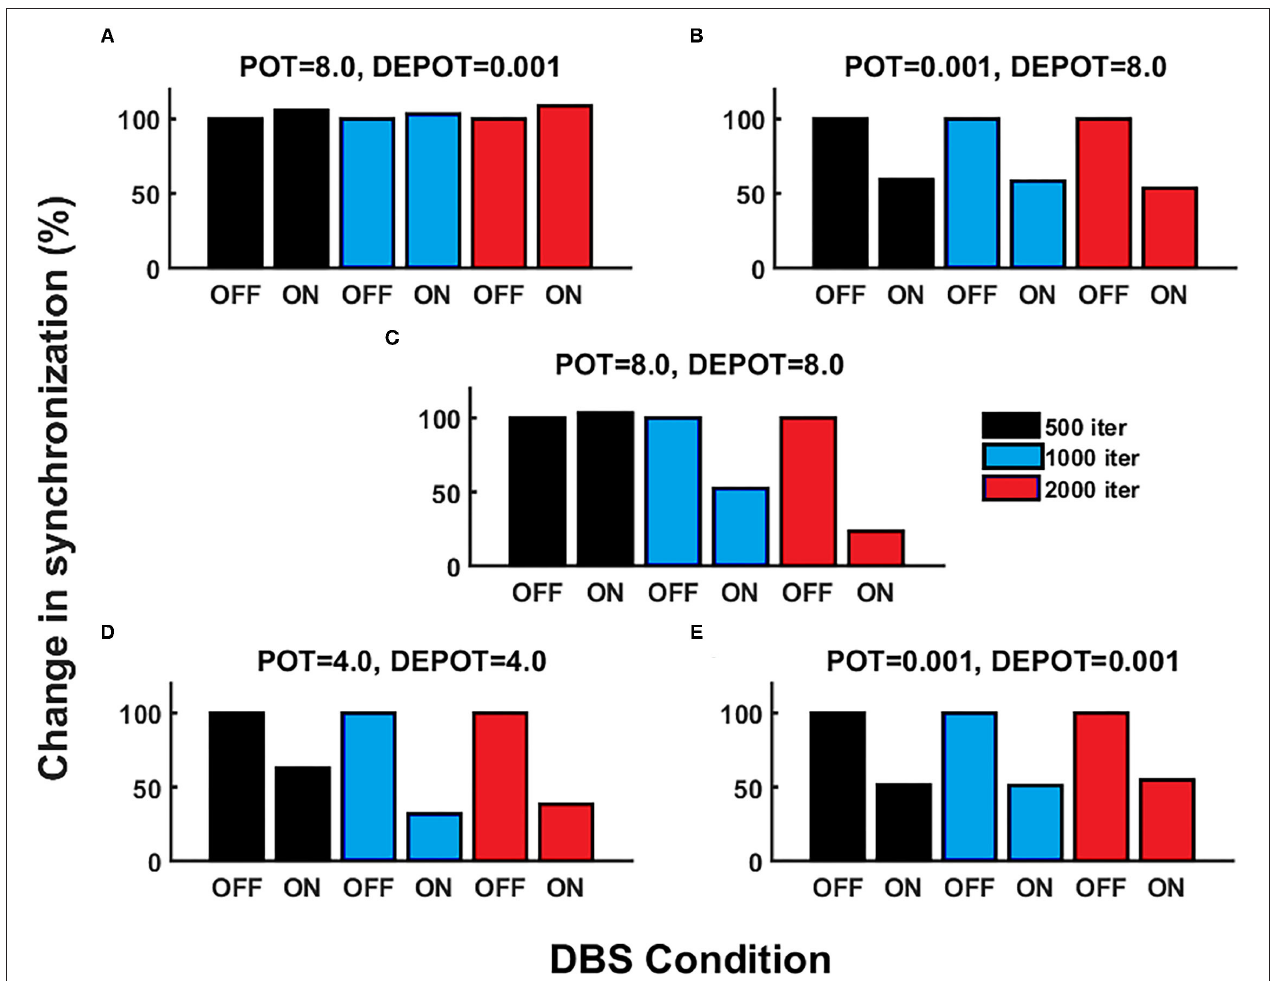
FIGURE 4 | The simulation results [percentage change of the grand average PLV, the initial DBS OFF represents the baseline level (100%)] corresponding to the influence of stimulation duration (500, 1,000, and 2,000 iterations) in de novo DBS “patients”: unbalanced potentiation and depotentiation (high and low level) (A,B) ; balance potentiation and depotentiation, i.e., equally high levels, (C) ; equally medium levels (D) ; and equally low levels (E)